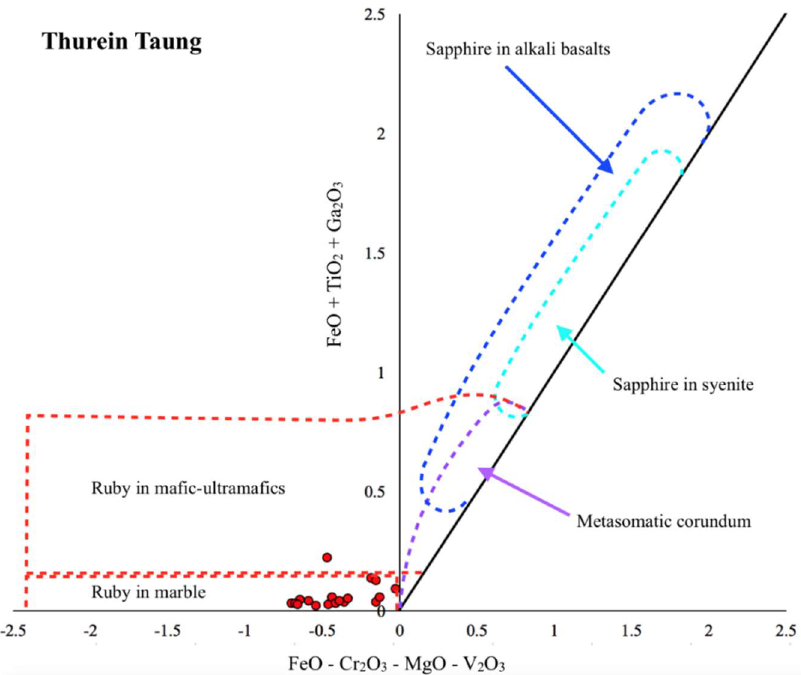
Figure 17. Discrimination metal oxide plots, with petrological fields after [3], for Thurein Taung ruby analyses. The plots are color-coded.